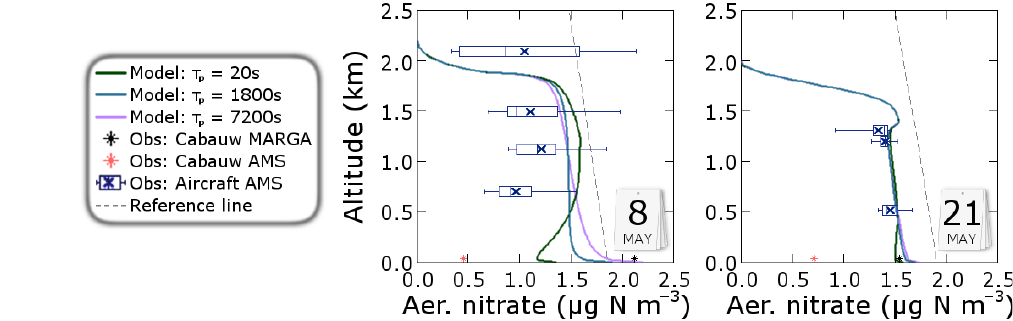
Fig. 7. Modelled aerosol nitrate profiles with partitioning timescales of 20s, 1800s and 7200s, at 15:30UTC for 8 May and at 11:30UTC for 21 May. Airbrone aerosol nitrate concentrations measured with the aerosol mass spectrometer, surface aerosol nitrate concentration measured with the aerosol mass spectrometer at Cabauw, and PM 10 observations by the MARGA instrument at Cabauw. The reference line shows a scaled concentration of 2.0µgNsm − 3 (scaled to standard temperature and pressure).